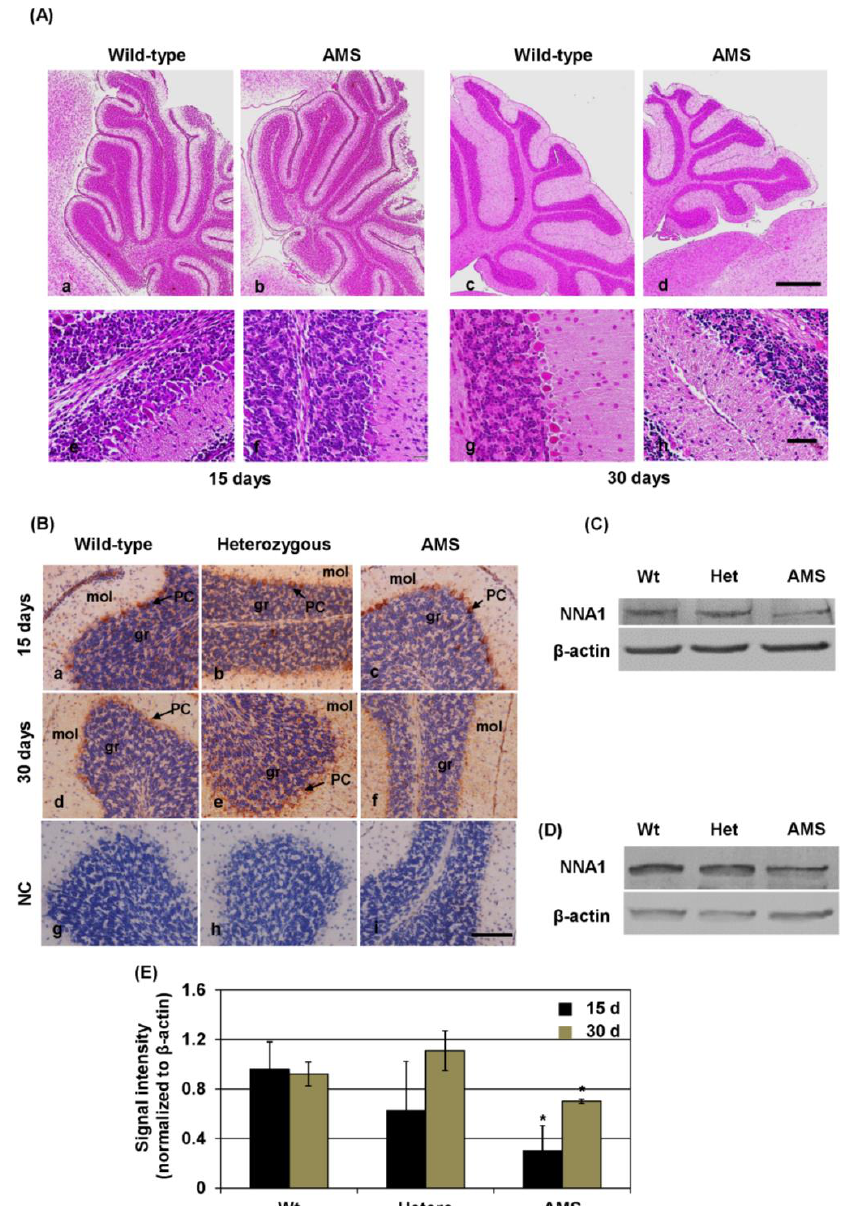
Figure 1. Pathological changes and NNA1 protein expression in the cerebellum of Ataxia and Male Sterility (AMS) mice: Pathological changes in the murine cerebellum were checked by hematoxylin and eosin staining. Photomicrographs of the cerebellum of wild-type ( a , c , e,g ) and AMS ( b , d , f,h ) mice at the ages of 15 ( a , b , e , f ) and 30 ( c , d , g,h ) days are shown in ( A ). The upper panels present photomicrographs at low magnification ( × 40), and the photomicrographs of the lower panels show the cerebellum at high magnification ( × 400). Scale bar: upper panel, 500 µ m; lower panel, 50 µ m. ( B – E ) The NNA1 protein expressions in the cerebellum of wild-type, Nna1 mutation heterozygous, and AMS mice were evaluated using immunostaining and Western blotting. ( B ) NNA1 immunostaining is shown here, where the photomicrographs (×200 magnification) of the upper and middle panels display cerebellar samples of 15- and 30-day-old mice, respectively. Cerebellar samples of 30-day-old mice were also stained with normal goat IgG as negative controls (NC) and are shown in the lower panels. Purkinje cells (PCs) are indicated using arrows. mol = molecular layer, gr = granular layer. Scale bar, 100 µ m. ( C , D ) The representative NNA1 Western blotting results of wild-type (Wt), Nna1 mutation heterozygous (Het), and AMS mice at the ages of 15 ( C ) and 30 ( D ) days are shown here. β -actin was used as a loading control. ( E ) Average densitometric data of the Western blotting normalized to β -actin ( n = 5) are presented in ( E ). Statistical significance is denoted as follows: * p < 0.05 vs.